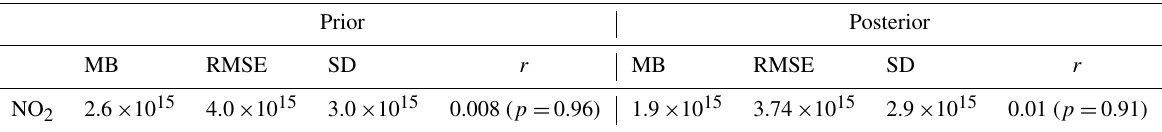
Table 5. Statistics for the comparison between simulated and observed NO 2 tropospheric columns for the inversion E , mainly over the Netherlands (see the area in purple in Fig. 6). MB = mean bias, RMSE = root mean square error, SD = standard deviation are in molec.cm − 2 . The spatial correlations r are presented with their p value.